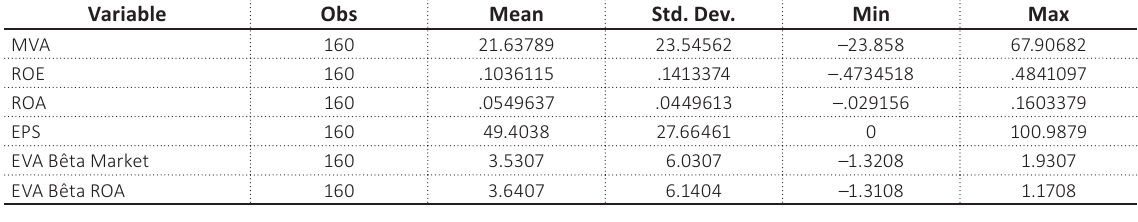
Table 3. Correlation study